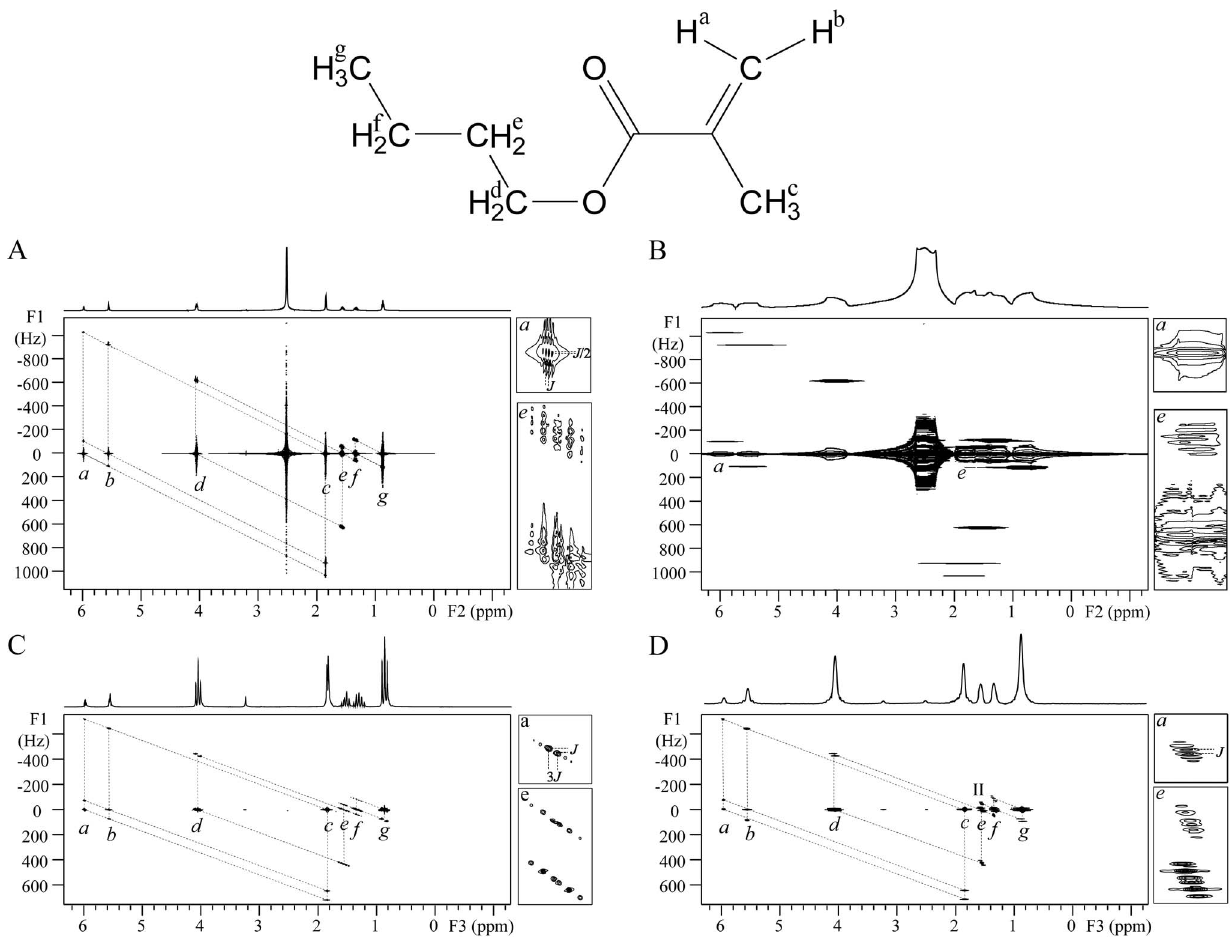
Figure 4. SECSY spectra of a solution of butyl methacrylate in DMSO. (A, B) Conventional spectrum with 1D projection along the F2 axis in a well-shimmed field (A) and in an inhomogeneous field with a line-width of 150 Hz (B); (C, D) spectra with 1D projection along the F3 axis in the same inhomogeneous field acquired from DDF-SECSY (C) and DDF-SECSY with ultrafast acquisition scheme (D). The regions of component peak of a and both component and cross peaks of e are expanded for comparison. The structure of butyl methacrylate with proton marked is shown on the top of the frame.